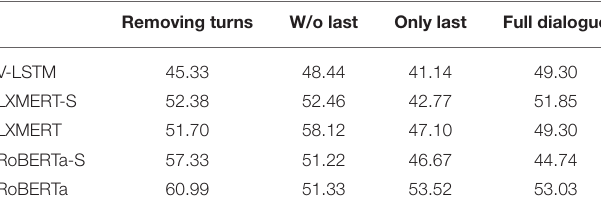
TABLE 10 | Error Analysis: Percentage of games in which each model does the same mistake made by humans (i.e., by selecting the same wrong candidate object as a human annotator).